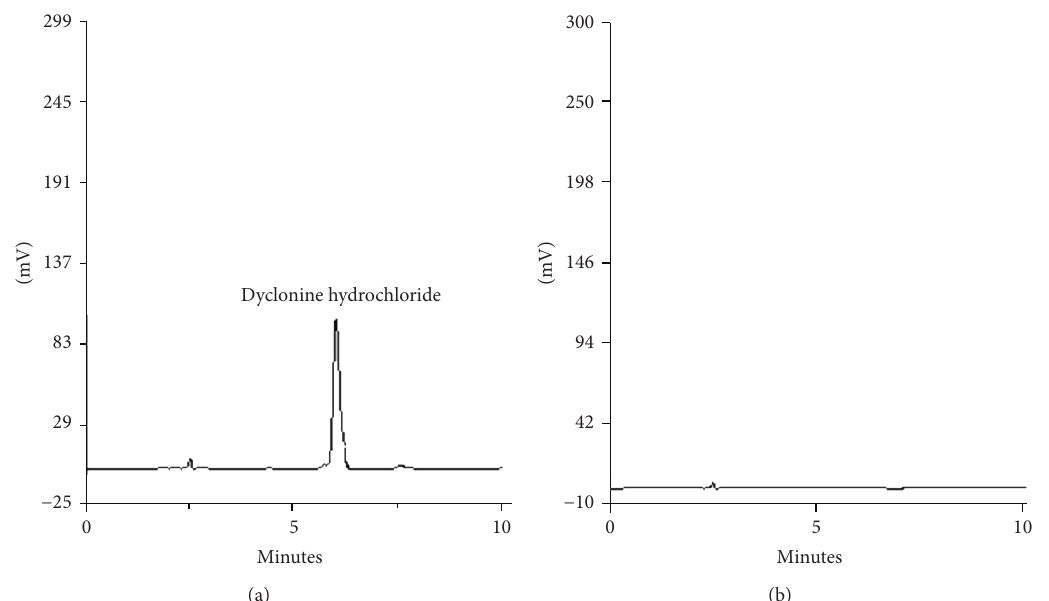
F 2: Typical HPLC chromatograms of dyclonine hydrochloride (20.0